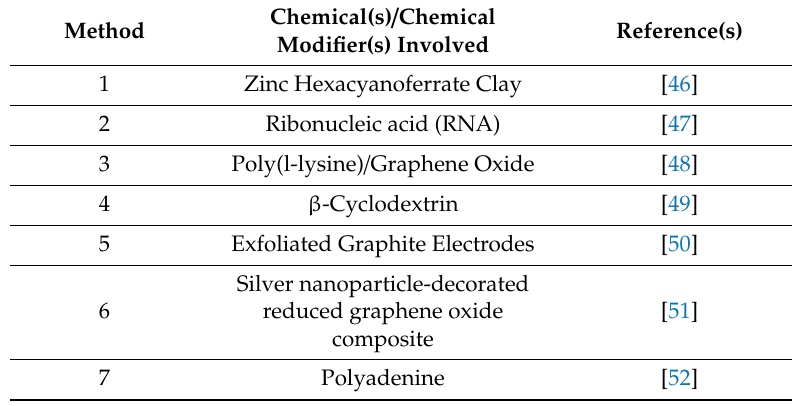
Table 1. Previously published approaches for simultaneous determination of UA and